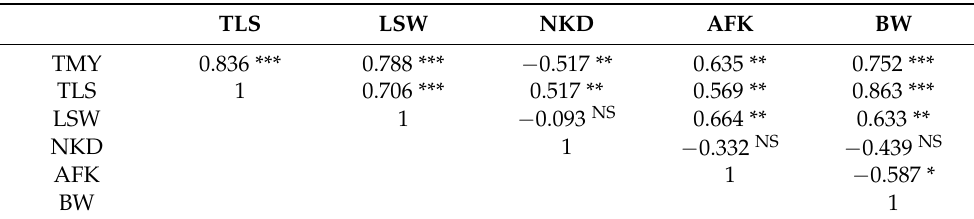
Table 4. Correlation coefficients between different factors related to culling risk in primiparous dairy Zaraibi goats.